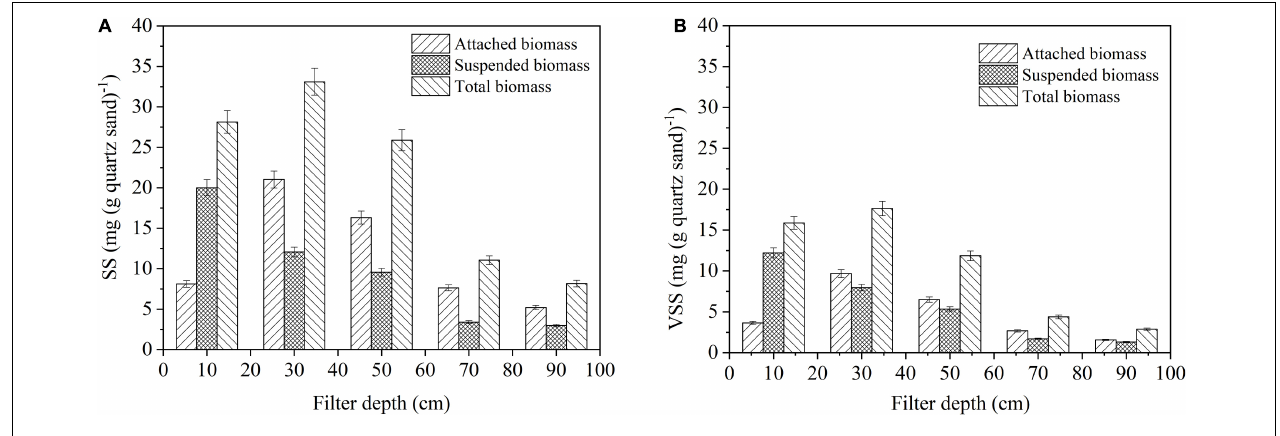
FIGURE 4 | Change of biofilm biomass along the DN-DBF depth (A) SS and (B) VSS.